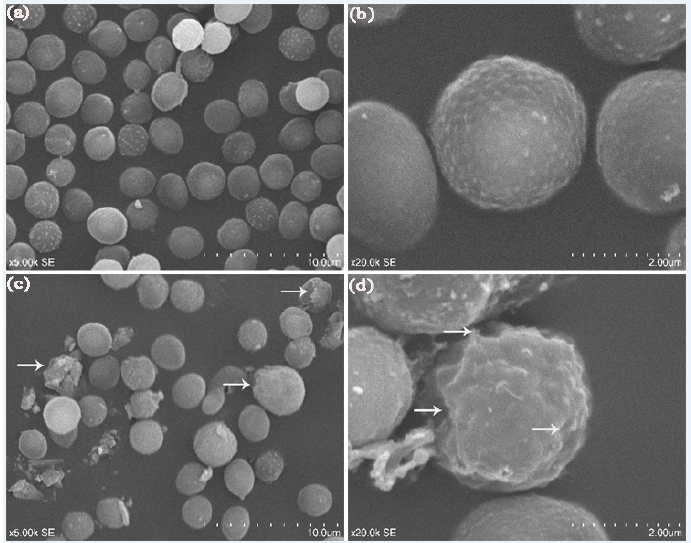
Figure 6. SEM of P. expansum. P. expansum conidia treated with distilled water ( a , b ), or BanTLP at 60 μ M ( c , d ) for 12 h. Arrows refer to the morphologic alterations in conidia, such as collapsed cell wall and severe contraction (magnification ×5000, and 20,000).